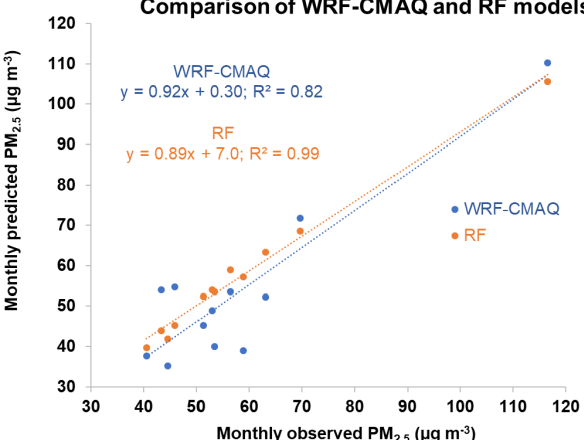
Figure 5. Comparison of predicted monthly average PM 2 . 5 mass concentrations by the WRF-CMAQ (Cheng et al., 2019) and RF model against observations in Beijing. WRF-CMAQ results are av- eraged over the whole Beijing region and the observed values refer to the average concentration of PM 2 . 5 over the 12